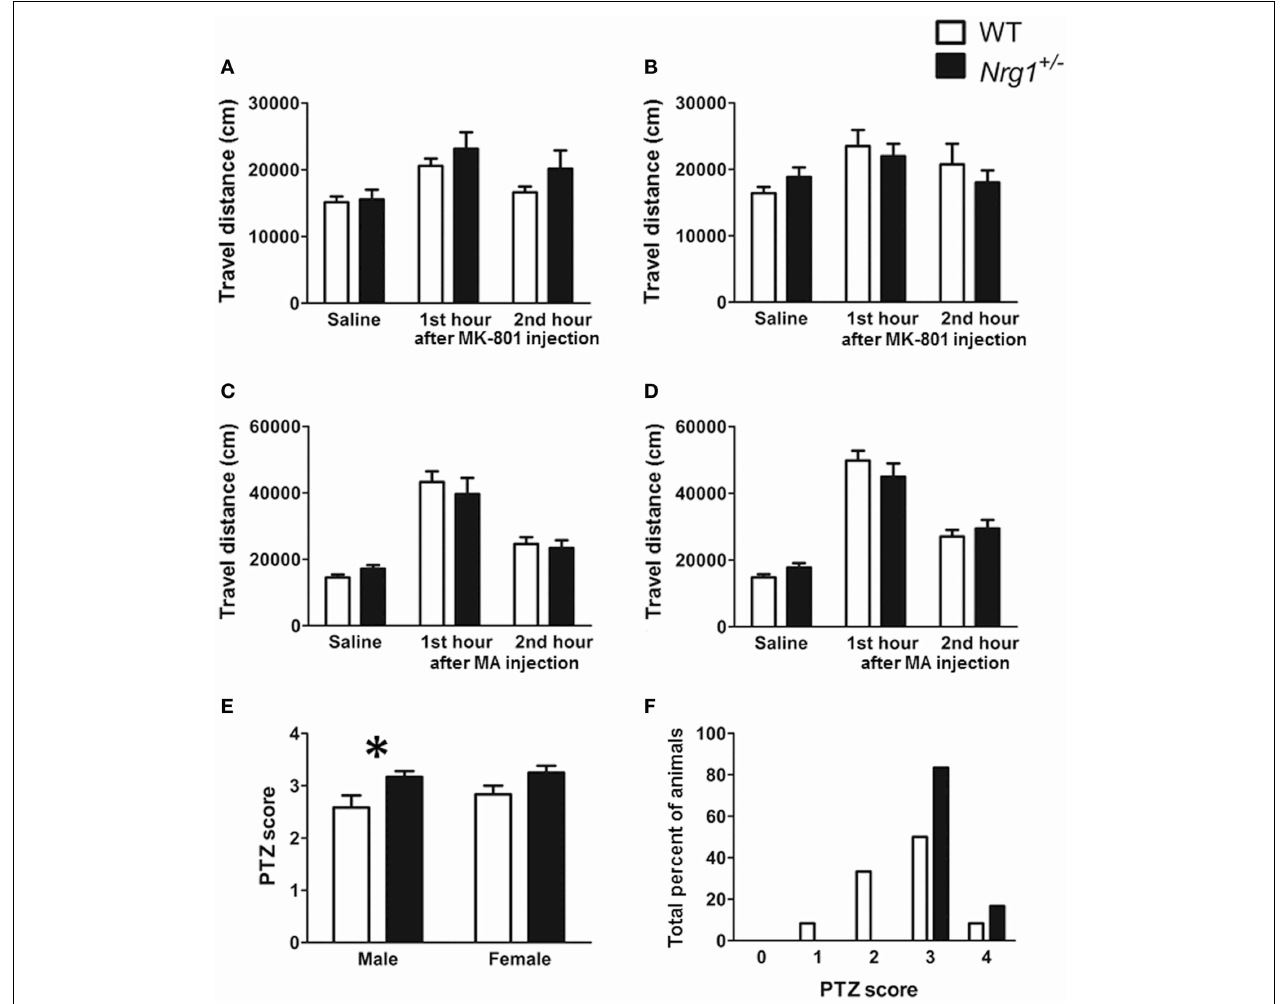
FIGURE 3 | Drug-induced behavioral alterations (mean + s.e.m.) in the novel TMc- Nrg1 + / − mice (black bars) and their wild-type controls (WT, white bars) ( n = 12 each group) of this study. (A,B) Total travel distances for the two groups of male and female mice during the 1-h saline baseline and the 1st and 2nd 1-h periods after the injection of MK-801 (0.25mg/kg, i.p.). (C,D) Total travel distances (mean + s.e.m.) for the two groups of male